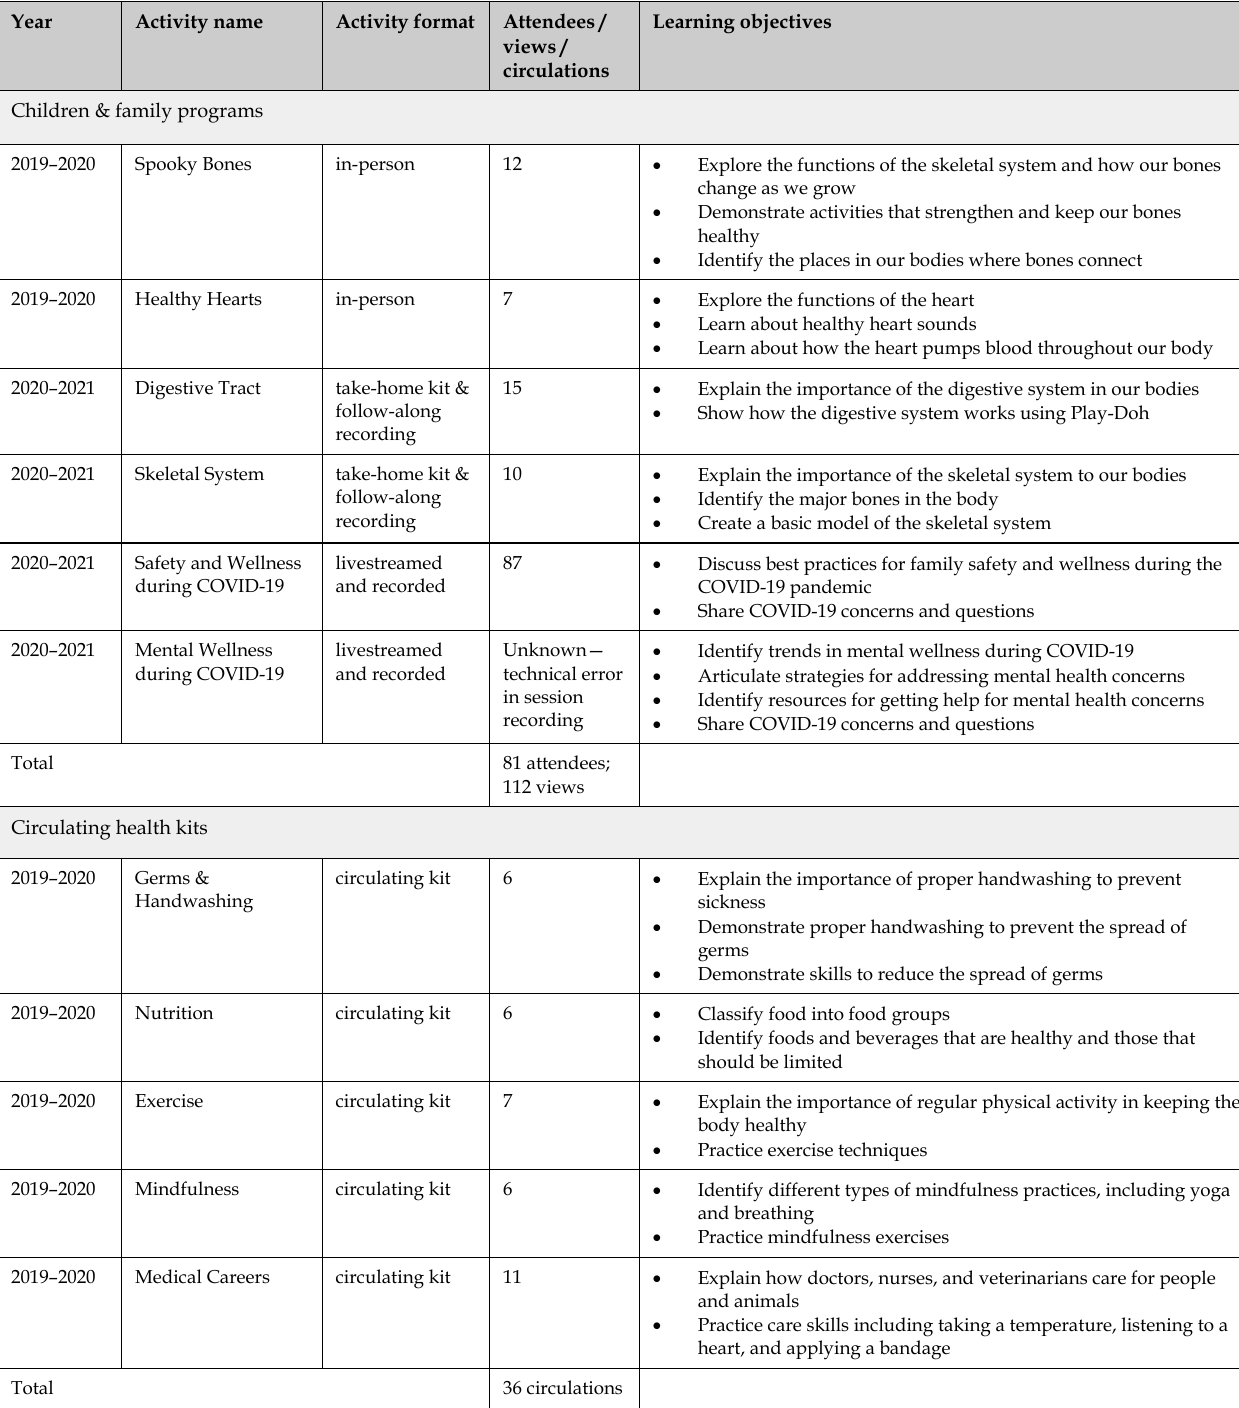
Table 1 Health education programs summary, 2018 – 2021